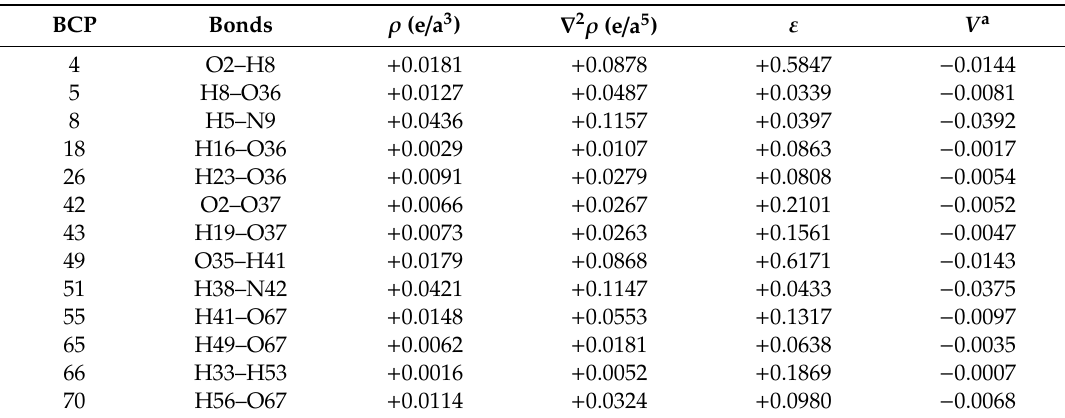
Table 4. AIM properties of selected values for the main interactions for HBPAH; electronic density ( ρ ), Laplacian of density ( ∇ 2 ρ ), ellipticity ( ε ) and density of potential energy ( V )